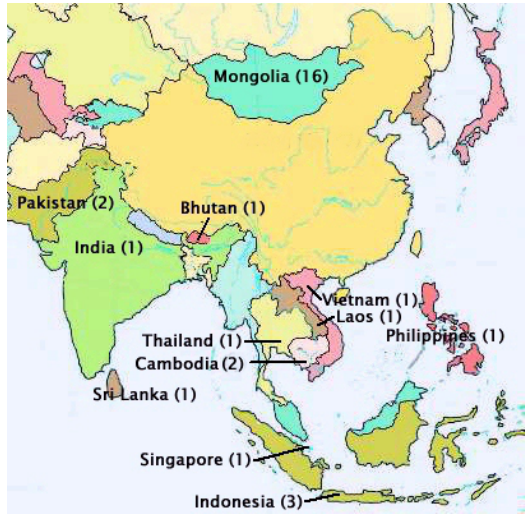
Figure 1. Number of respondents in each country (Study